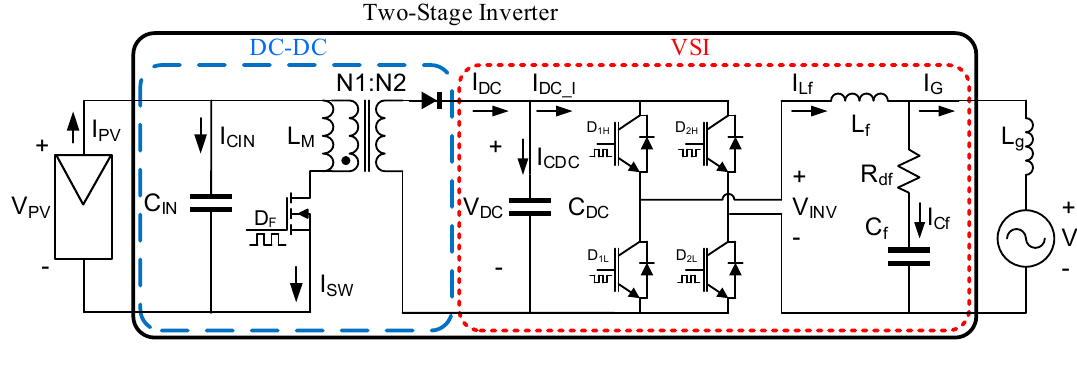
Figure 1. Two-stage grid-connected inverter.